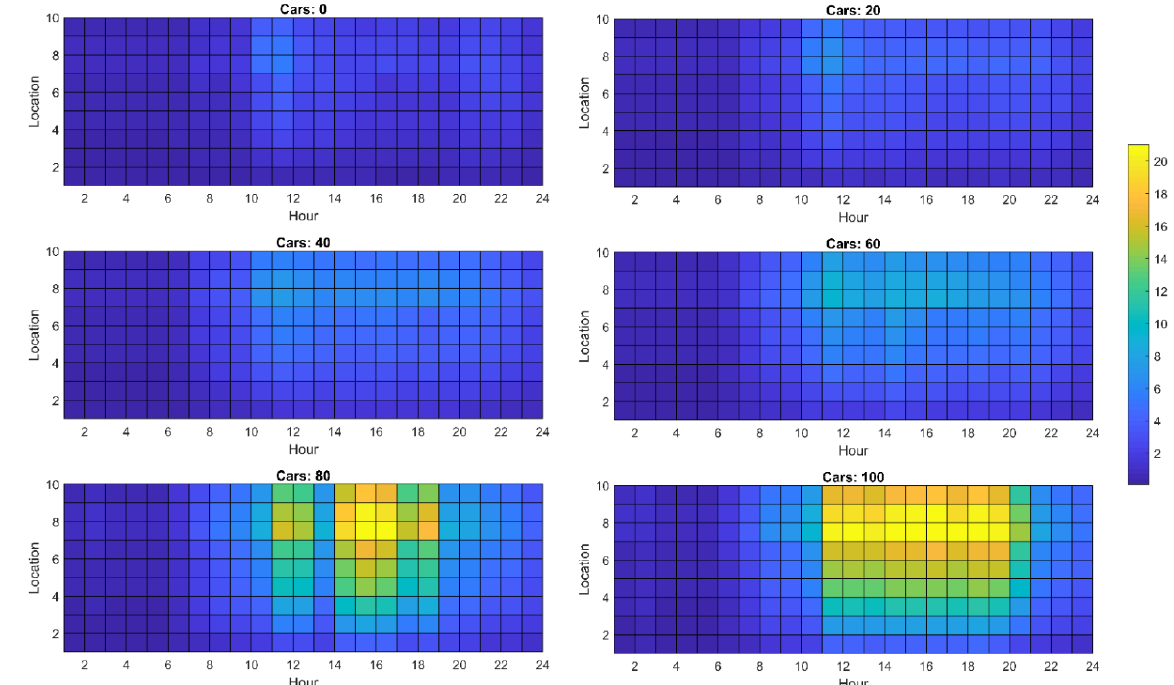
Figure A2. Peak voltage drops (percentage) observed in the network 1—plotted against terminal location and time of the day.